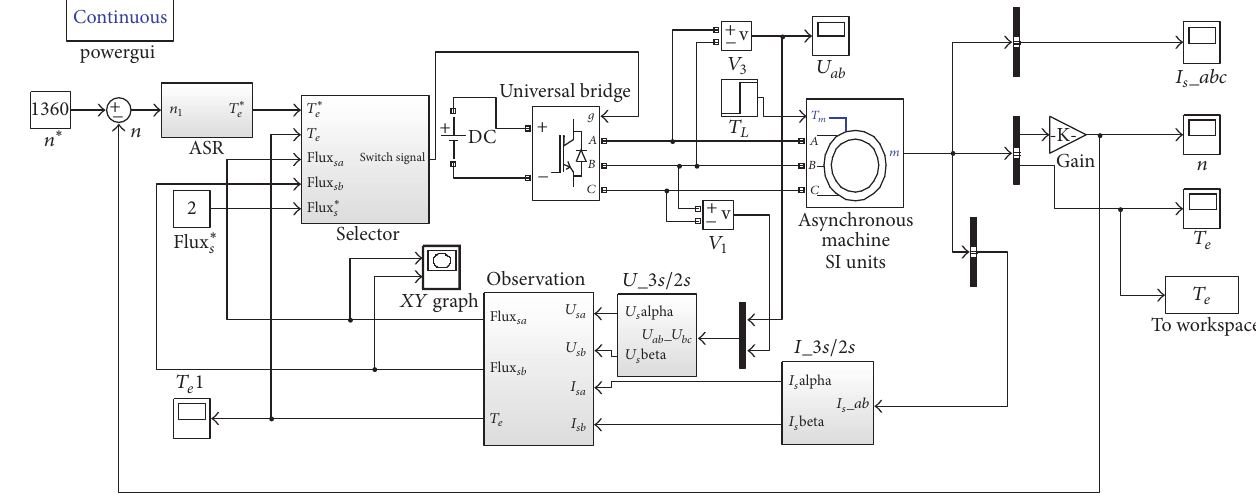
Figure 2: Direct torque control system of three-phase asynchronous motor.